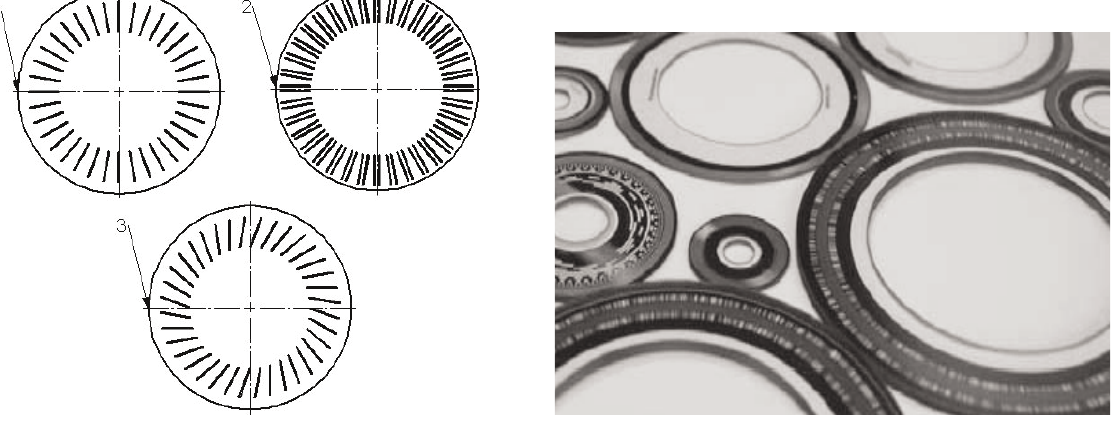
Fig. 1. Some types of circular scales: 1 – raster scale, 2 – scale with double (bifiliar) strokes, 3 – raster scale with decentring strokes